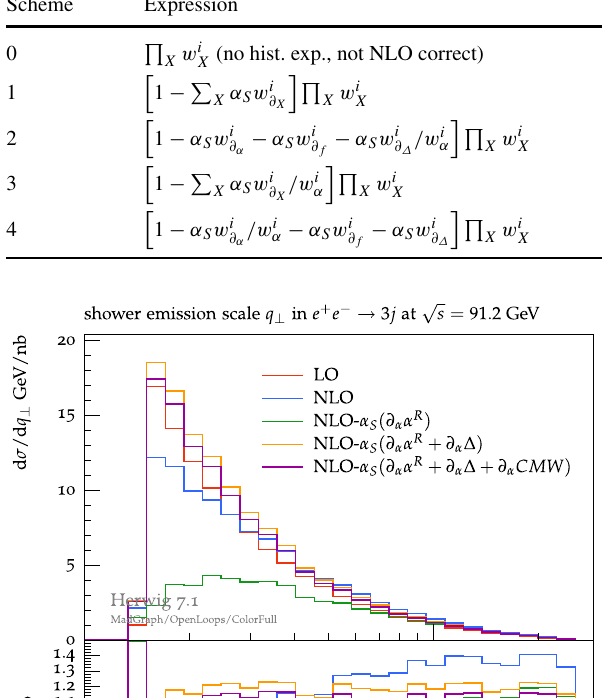
Table 1 Expansion schemes considered for the treatment of terms beyond NLO Scheme Expression